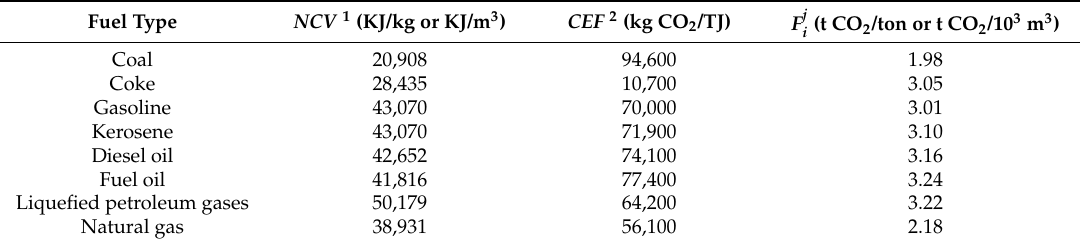
Table 2. CO 2 emissions per unit of fuel combustion in China in 2010.